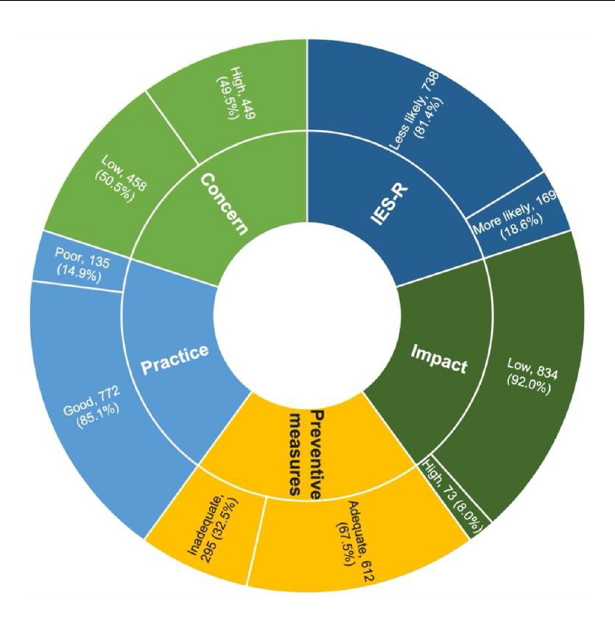
FIGURE1 Percentage of concerns, practice, adequacy of preventive measures, impact, and IES-R score among HCWs in Klang Valley.